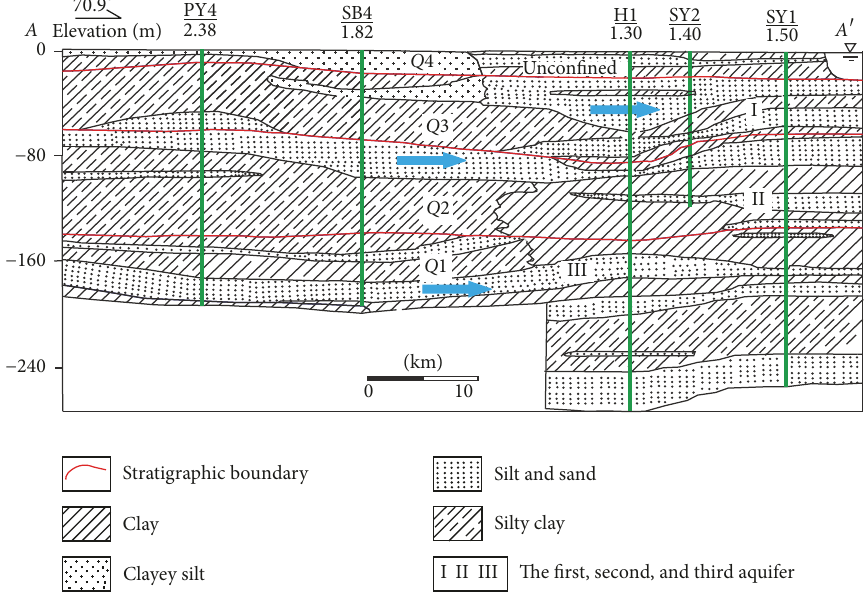
II IIII Figure 2: A-A 󸀠 cross-section of the study area. SY1 and SY2 cores are displayed in the